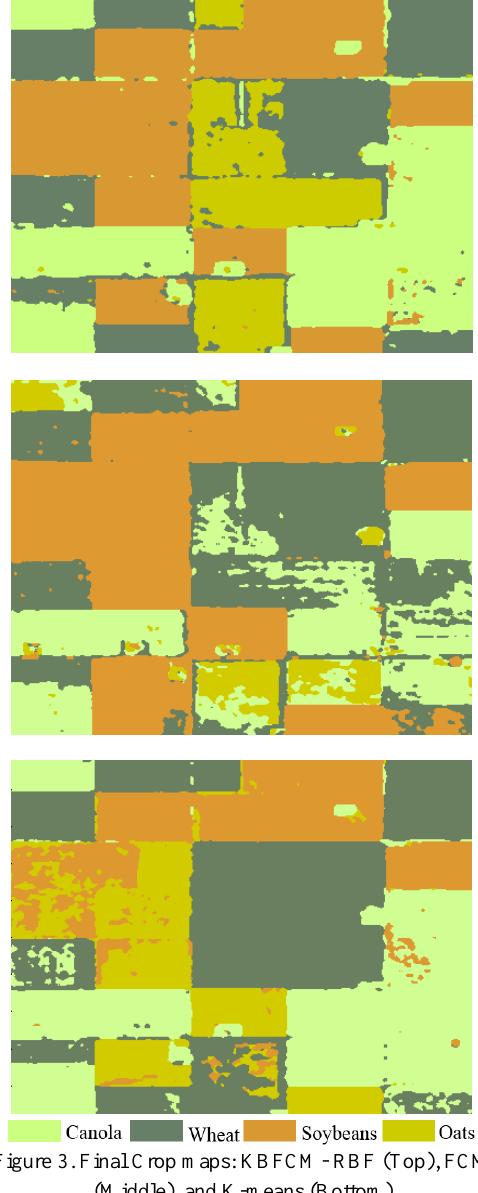
Figure 3. Final Crop maps: KBFCM- RBF (Top), FCM (Middle), and K-means